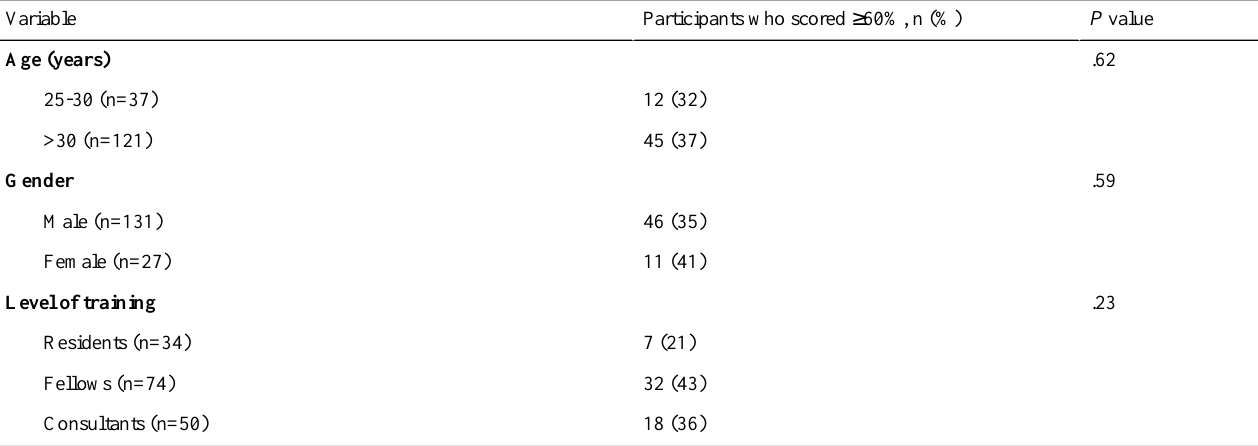
Table 2. Comparison of age, gender, and designation of participants in the high-score group (n=57).